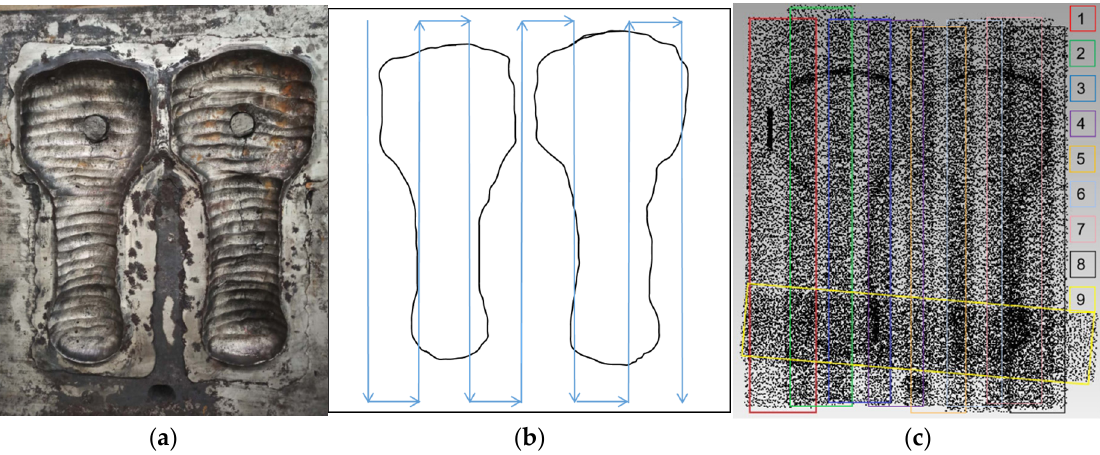
Figure 6. The point cloud model acquisition process. ( a ) Import failed mold; ( b ) path planning diagram; ( c ) point cloud data diagram after the OICP registration.